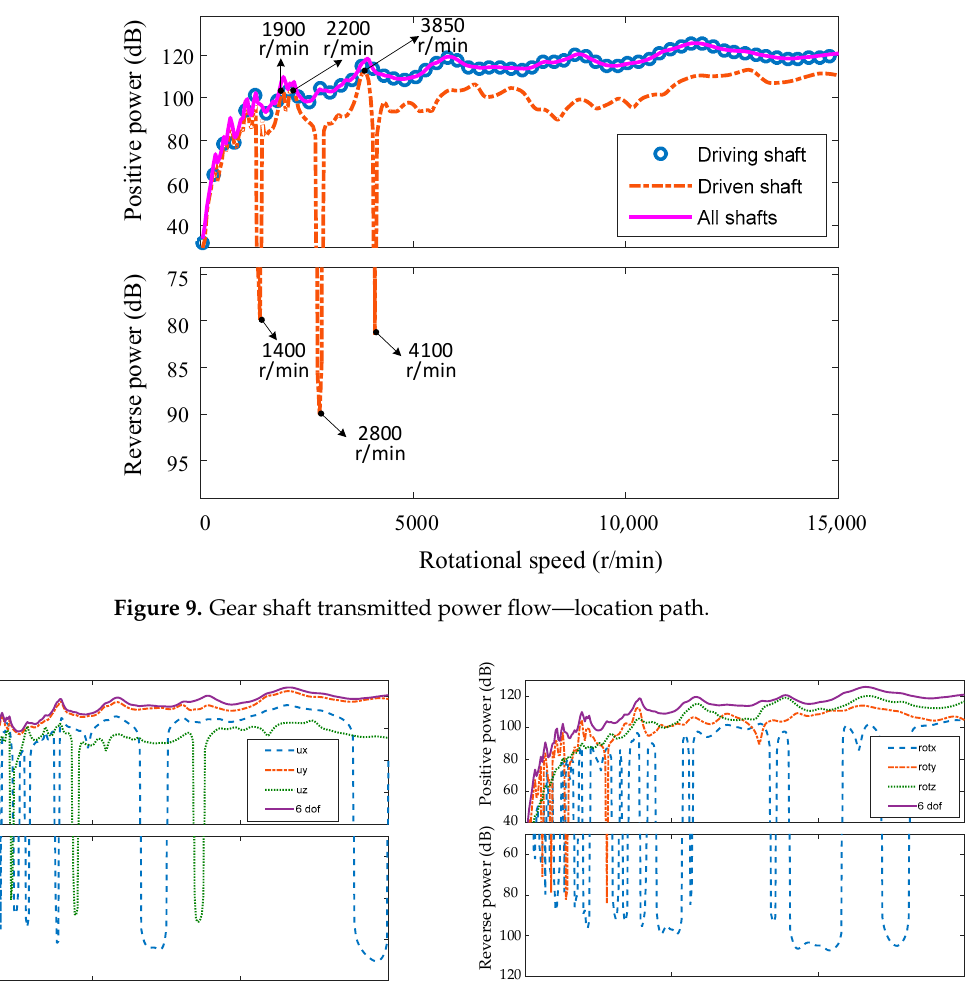
( b ) Rotational DOF Figure 8. Excitation power fl ow of gear pair—direction path. 4.2. Gear Shaft Transmi tt ed Power Flow Equations (25) and (27) are used to calculate the transmi tt ed power of gears to shafts in each location path. The transmi tt ed power of the location path corresponding to the gear shaft is shown in Figure 9. It can be seen that most of the vibration power of the gears is transmi tt ed to the driving shaft. The driven shaft receives certain vibration power only at some special resonance speed, such as 1900 r/min, 2200 r/min, and 3850 r/min. The average power of the driving shaft in the whole speed range is 111.3 dB, which is close to